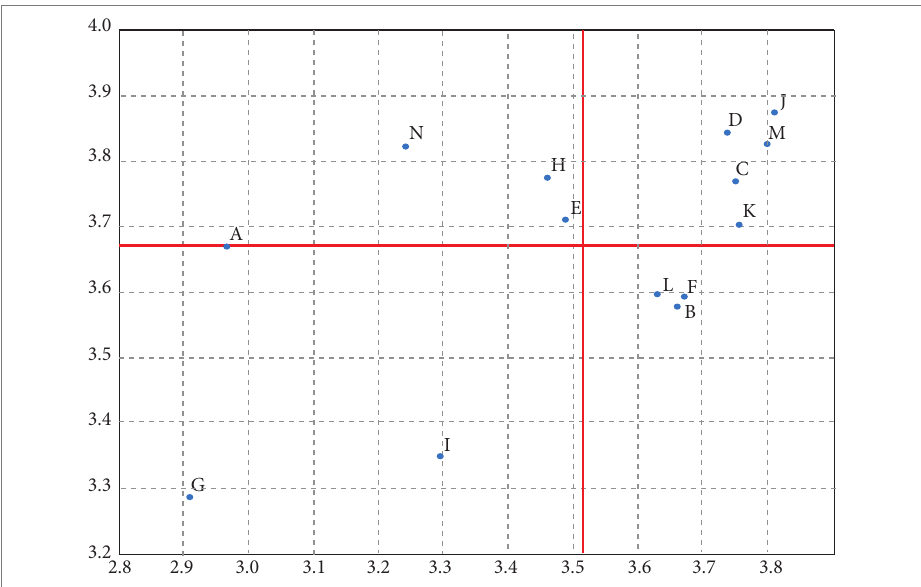
Fig. 9. The scatter diagram of parameters of relations of Slovak enterprises with the material supplier